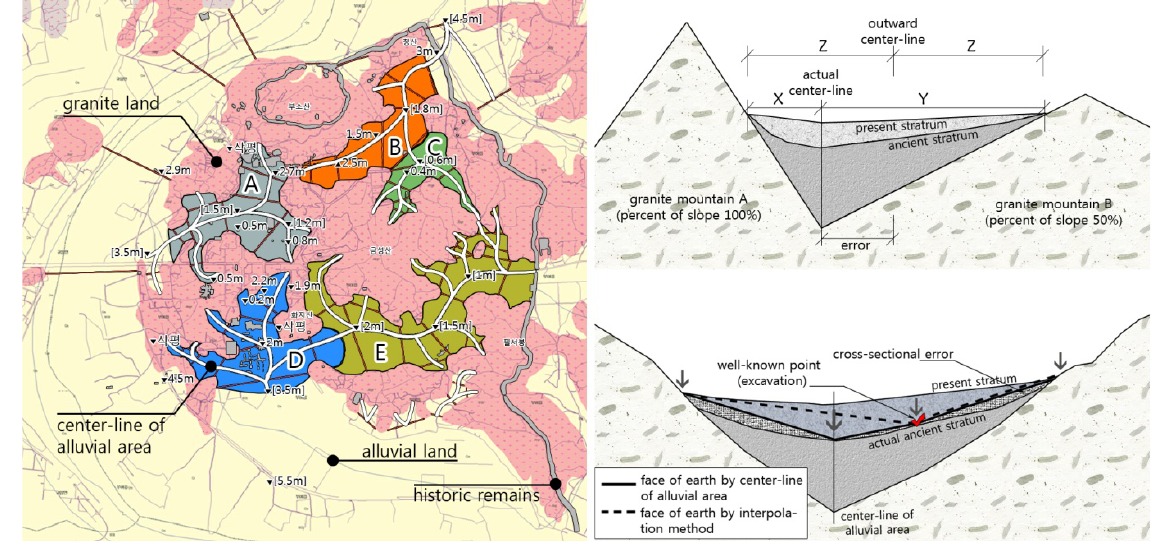
Figure 4. Ancient topographic analysis around the alluvial